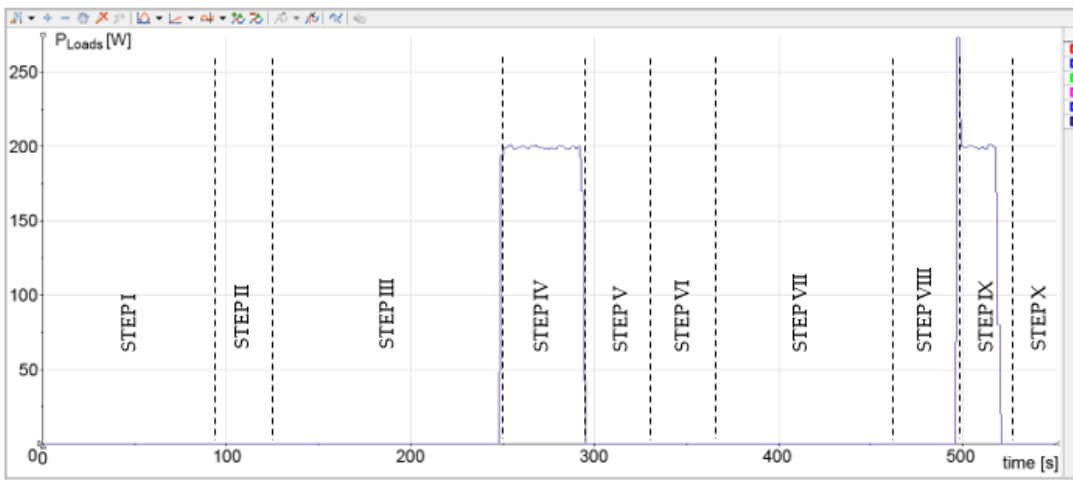
Figure 15. Power exchanged from the SUN with the grid.